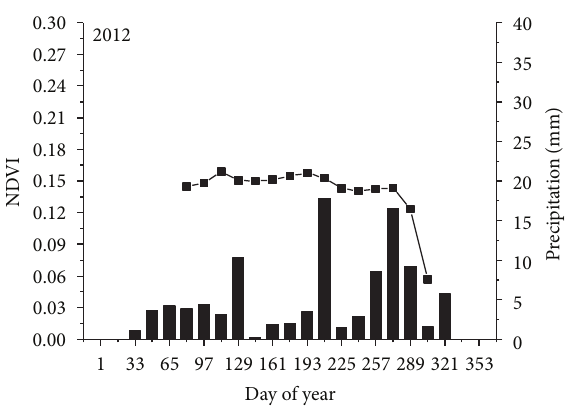
Figure 2: NDVI (only show the growing season) and precipitation in each 16-day period of the year from 2004 to 2012 for the shrubland within Gurbantunggut Desert.